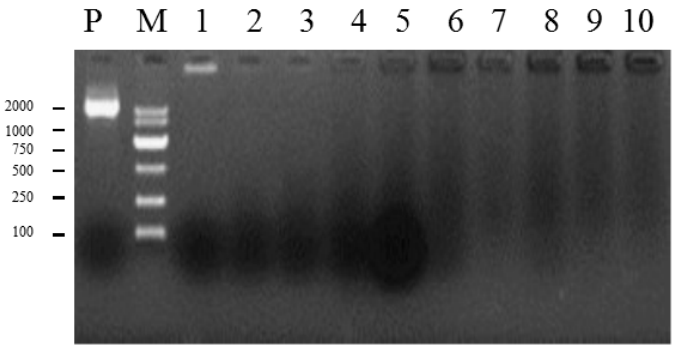
Figure 3. Gel electrophoresis of plasmid DNA (lane P) and plasmid DNA – liposome (lanes 1–10) composed of 1 µg plasmid DNA and 1–10 µL liposome. Lane P, naked plasmid DNA. Lane M, Marker DL2000. Lanes 1–10, 1 µg plasmid DNA mixed with 1, 2, 3, 4, 5, 6, 7, 8, 9, and 10 µL liposome,